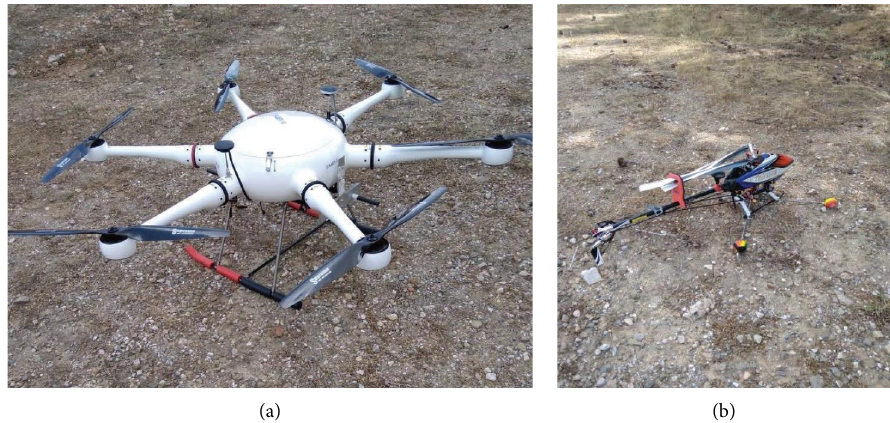
Figure 5: UAS models used during experimental sessions: (a) hexacopter and (b) small helicopter. Table 1: Approximation of Doppler responses (peaks) from hovering UAS. Flight altitude (m)